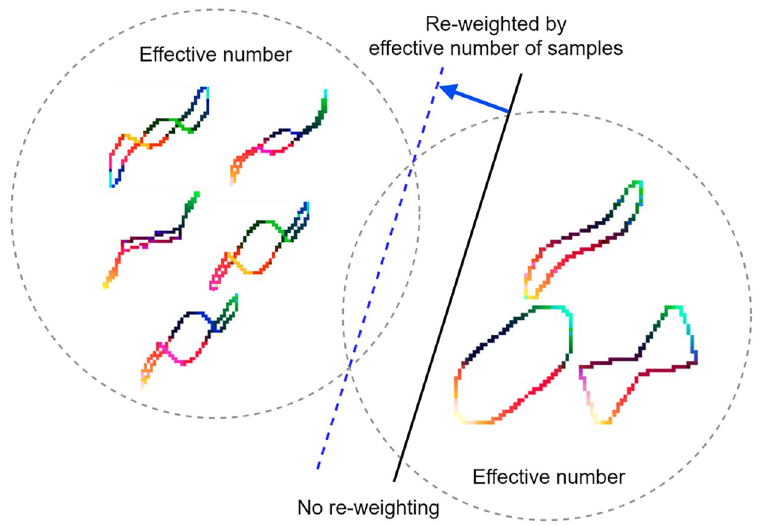
Fig 8. The schematic diagram of the reweighted optimal classifier model.